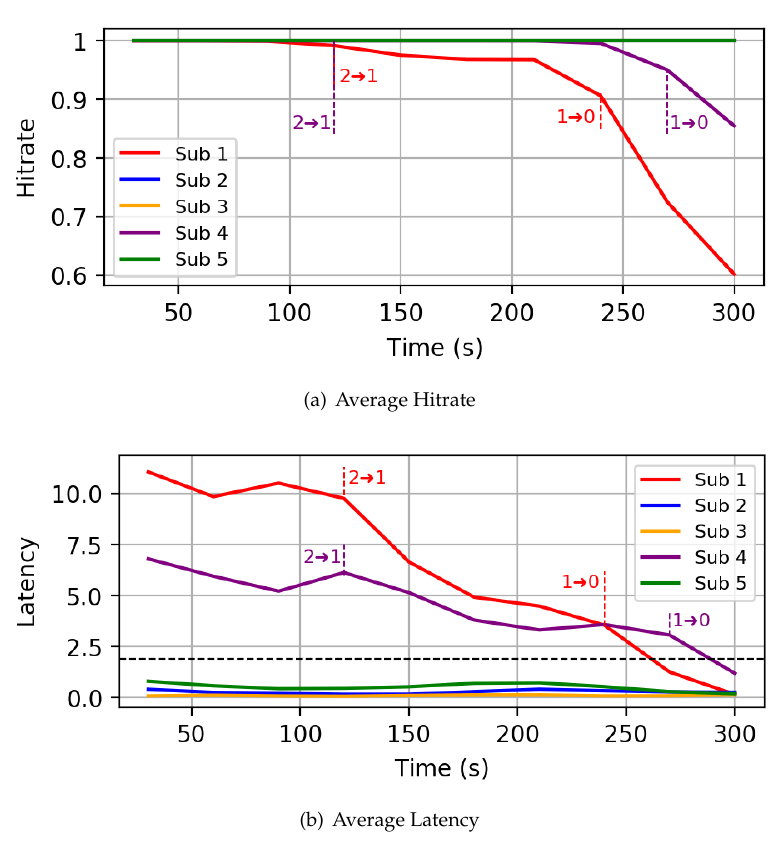
Figure 12. Latency-constrained mode